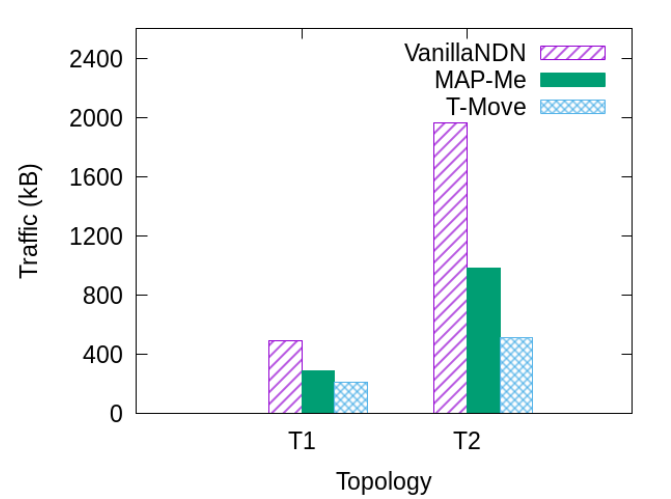
Figure 7. Average traffic for Topologies 1 and